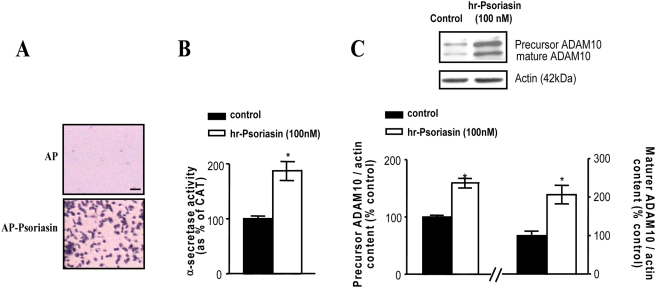
S100A7 receptor-binding activity in human platelets and modulation of α-secretase activity and ADAM-10 expression in platelet cells by S100A7 exposure.In this study, human platelet was prepared from blood collected from a cognitively normal control case. Cultured platelets were used for AP-S100A7 ligand-binding assay (bottom); parallel study using AP served as control staining (A). B, C, cultured platelets were treated with 100 nM h-S100A7 for 24 hours; parallel platelet cultures treated with vehicle served as controls. B, α -secretase activity in platelet lysates assessed using the α-secretase activity kit (R&D Systems). C, precursor and mature ADAM-10 content assessed by western blot analysis. Inset, representative western blot analysis of precursor and mature ADAM-10 in platelet lysates. B, C, values represent mean±SEM and are shown as percent of control cells; n = 3 independent cultures per group. *P<0.05, two-tailed Student t-test, hr-S100A7 vs. control group.